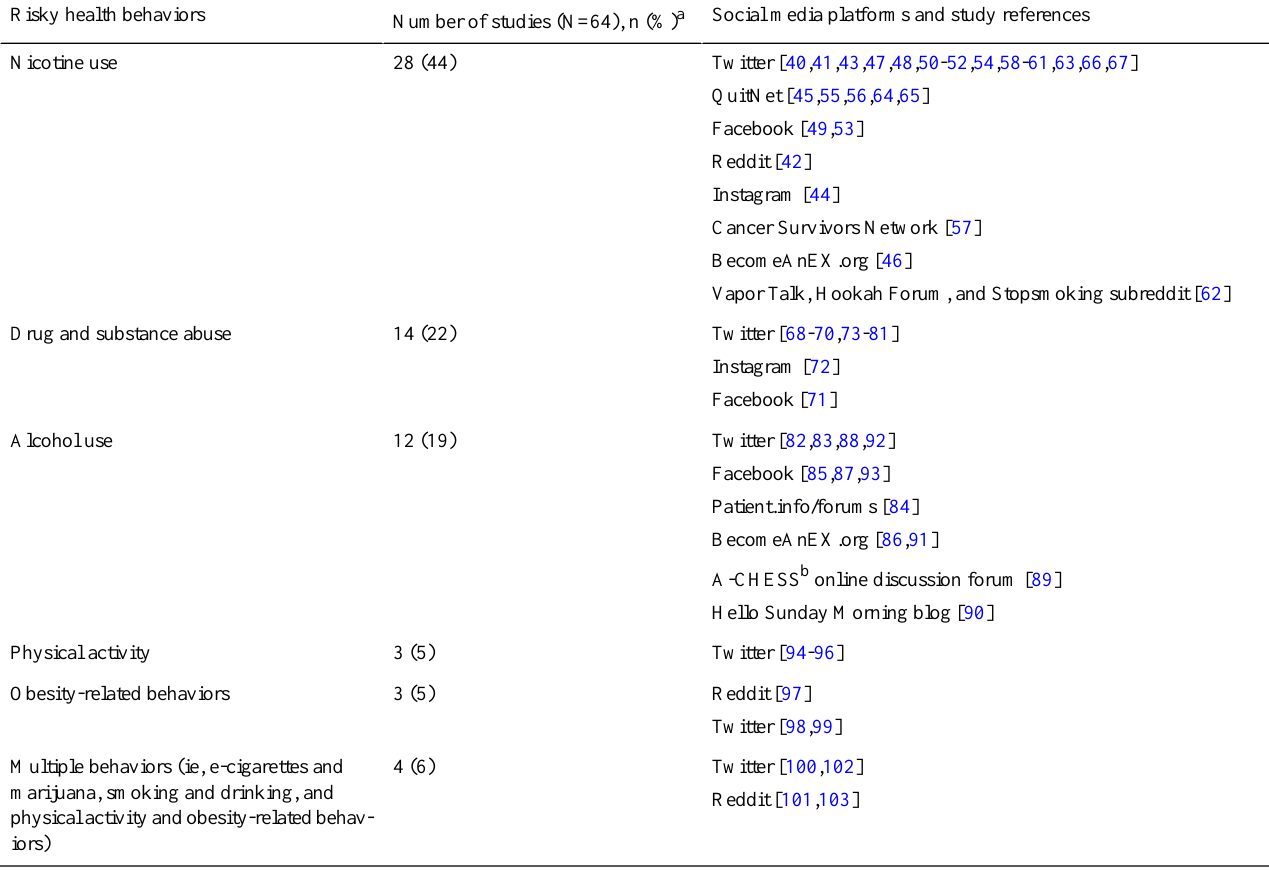
Table 2. Risky health behaviors and their associated social media